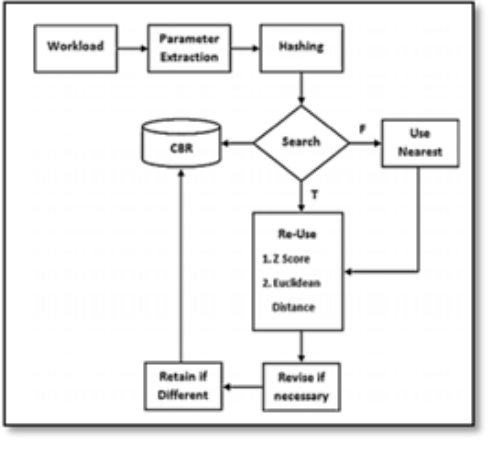
Figure 2. CBR structure